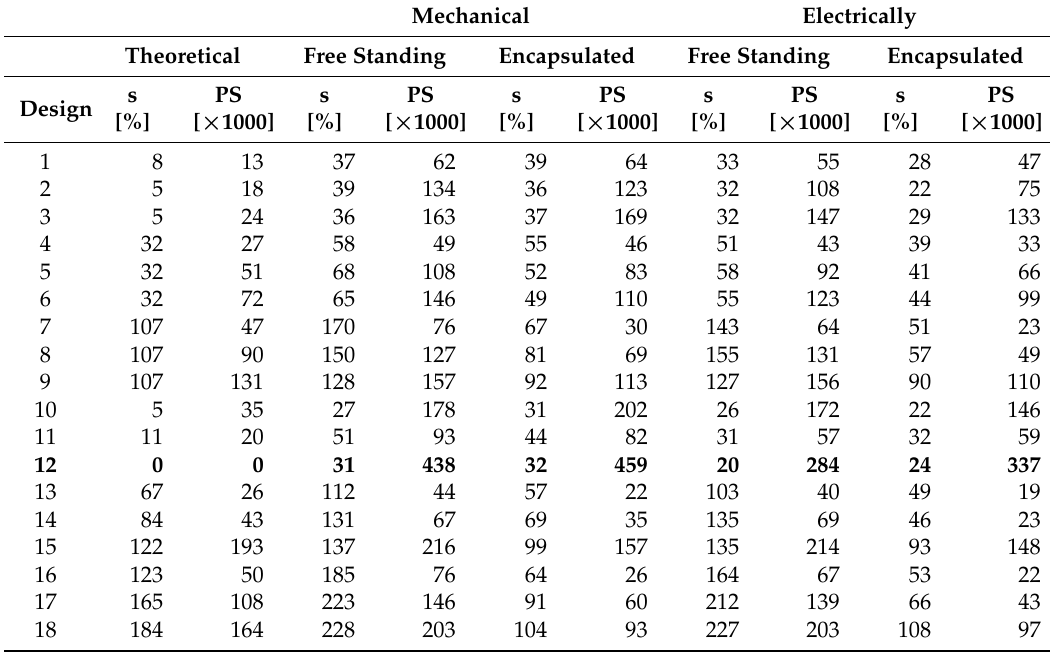
Table 4. Average stretchability and planar stretchability (PS) of the tested interconnects.